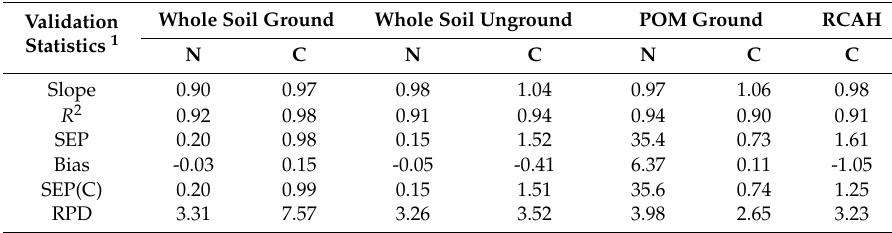
Table 5. Validation statistics for whole and ground soil carbon (TSOC) and nitrogen (TSN), particulate organic matter carbon (POMC) and nitrogen (POMN), and residual C of acid hydrolysis (RCAH). 2 Whole Soil Ground Whole Soil Unground POM Validation Statistics 1